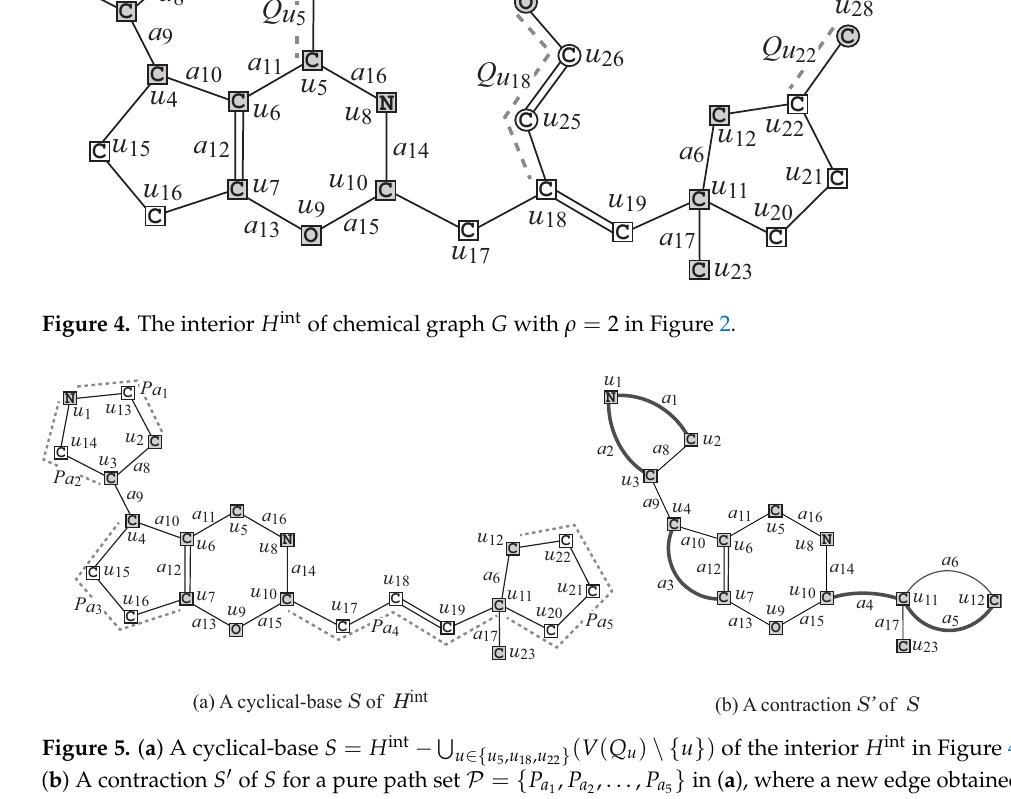
Figure 5. ( a ) A cyclical-base S = H int − (cid:83) u ∈{ u ( b ) A contraction S (cid:48) of S for a pure path set P = { P a by contracting a pure path is depicted with a thick